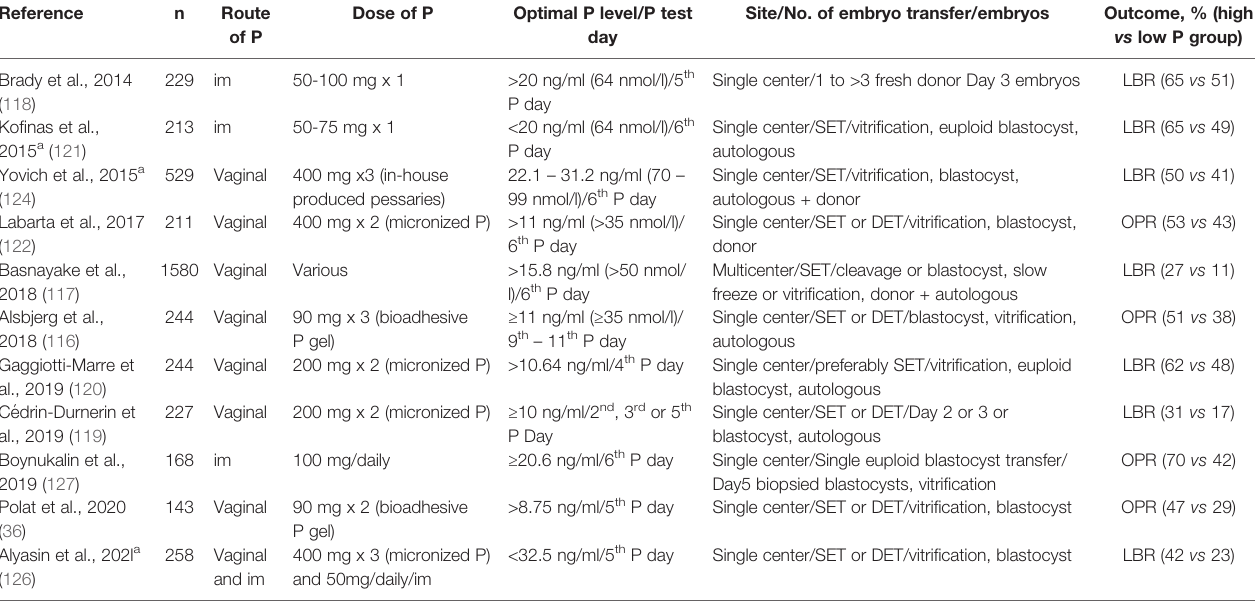
TABLE 2 | Overview of studies on serum progesterone (P) monitoring in HRT cycles.